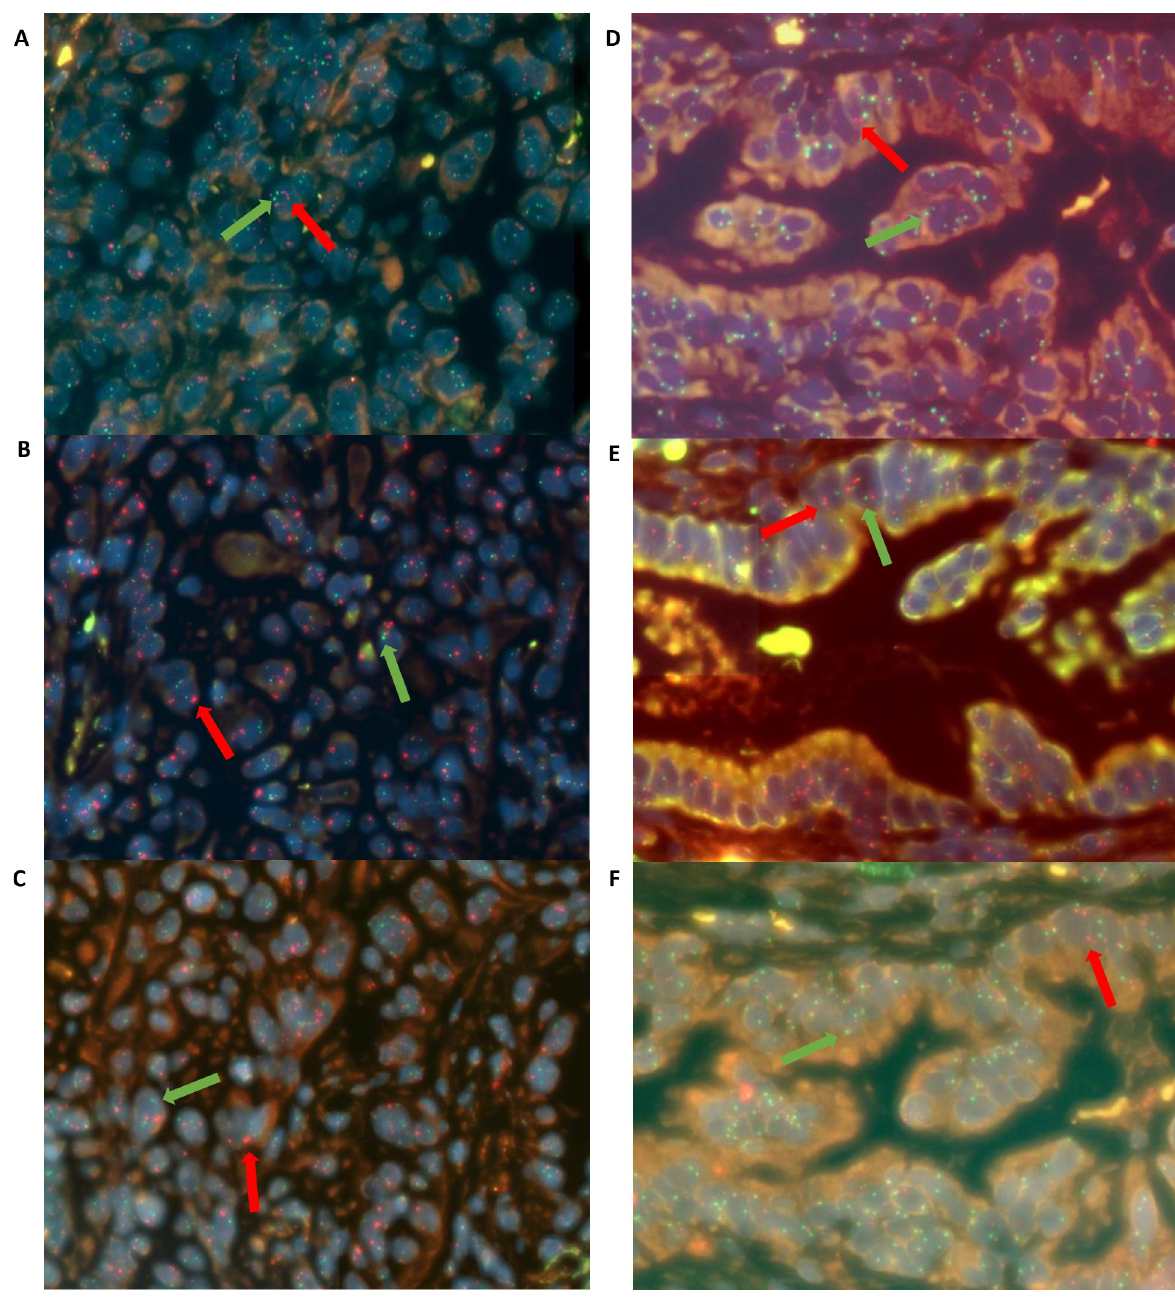
Fig 3. Probe hybridisation to NSCLC cases showing marginally increased and normal MET gene copy number. Probe hybridisation efficiency was reproducible between the Standard Kreatech assay (A, D), fast Dako assay (B, E) and fast Kreatech assays (C, F). Tissue with increased (A, B, C) and normal gene copy number (D, E, F) are shown. Red fluorophore is conjugated to probe specific to MET gene (specific examples highlighted with red arrows), green fluorophore is conjugated to probe specific for chromosome 7 centromere (highlighted with green